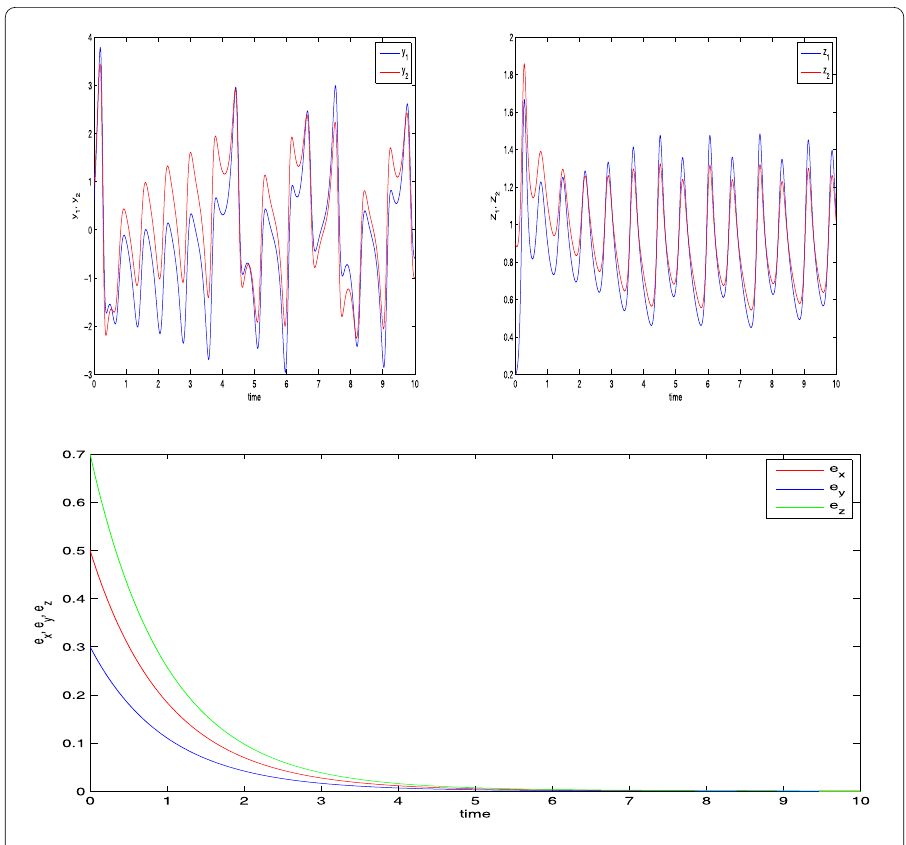
Figure 8 Time domain response for y 1 , y 2 , z 1 , z 2 and the error functions e x , e y and e z for both systems when α 1 = α 2 = α 3 = 1 and δ = 5, γ = 0.5, R =